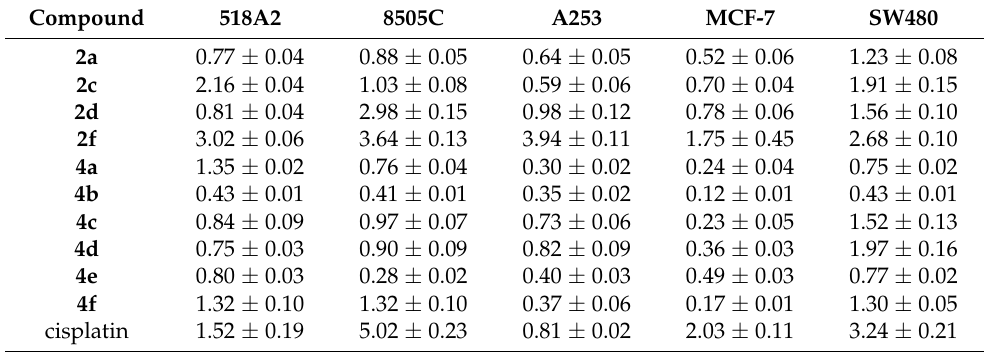
Figure 5. Representative graphs showing the survival (in %) of cells growth for 96 h in the presence of increasing concentrations of 4b (as an example, * p < 0.05). Table 1. IC 50 [ μ M] values of complexes 2a , 2c , 2d , 4a – 4e as well as 2f [34] and 4f [35] and cisplatin.